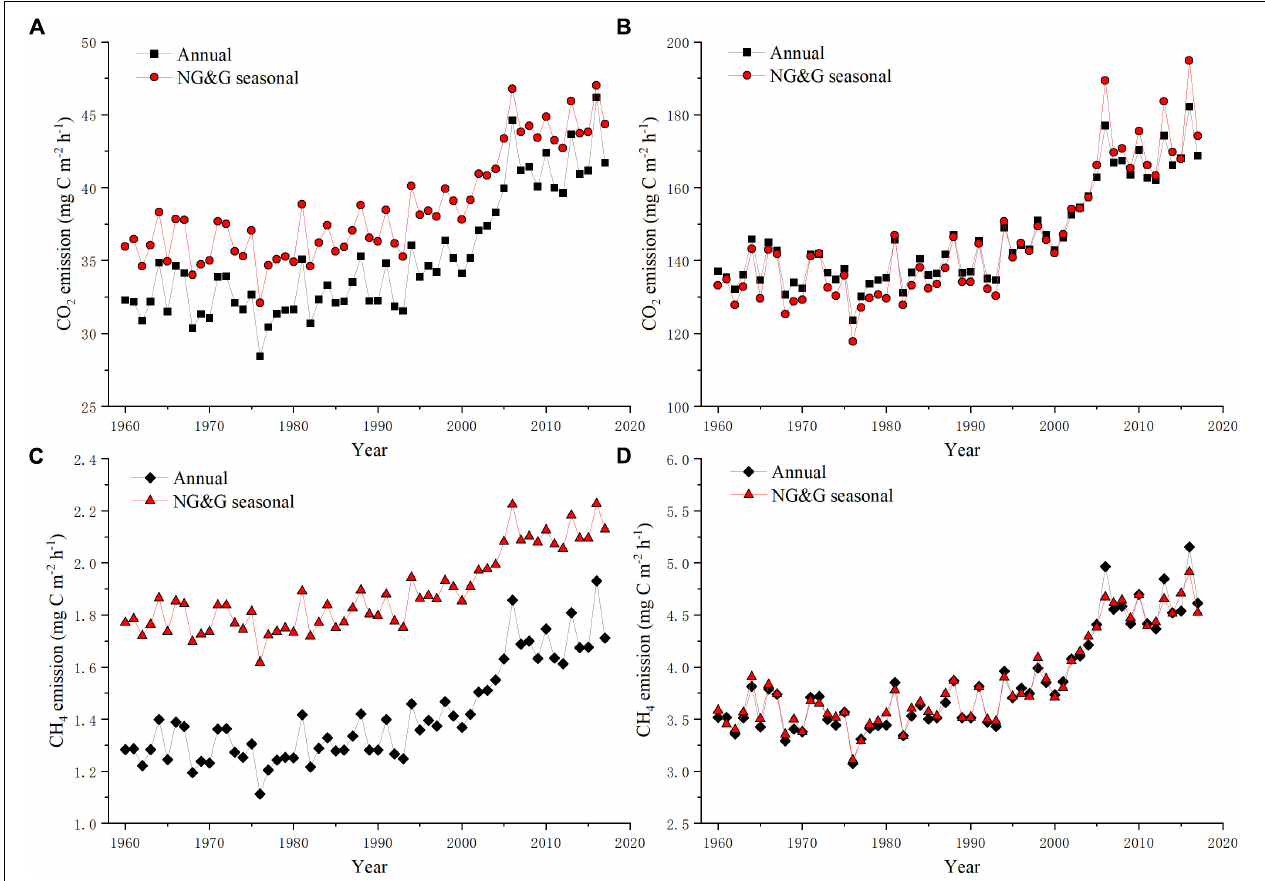
FIGURE 4 | Annual CO 2 and CH 4 emission rates of the study site from 1960 to 2017 were extrapolated based on regression models between soil temperature and CO 2 /CH 4 emissions measured using the static chamber method (A,C) and using the eddy covariance method (B,D) at different timescales (Annual or NG&G seasonal).